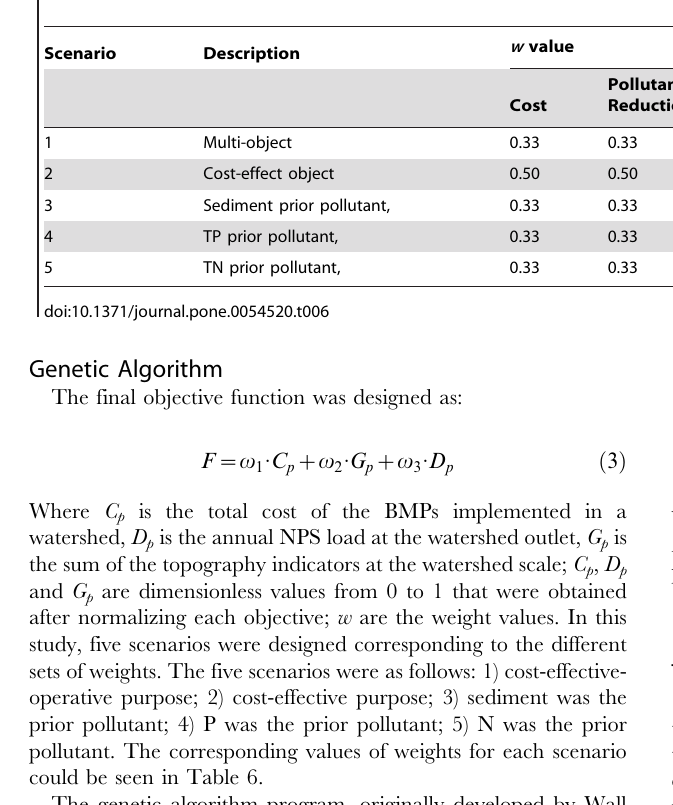
Table 6. The corresponding values of the w for each scenario.